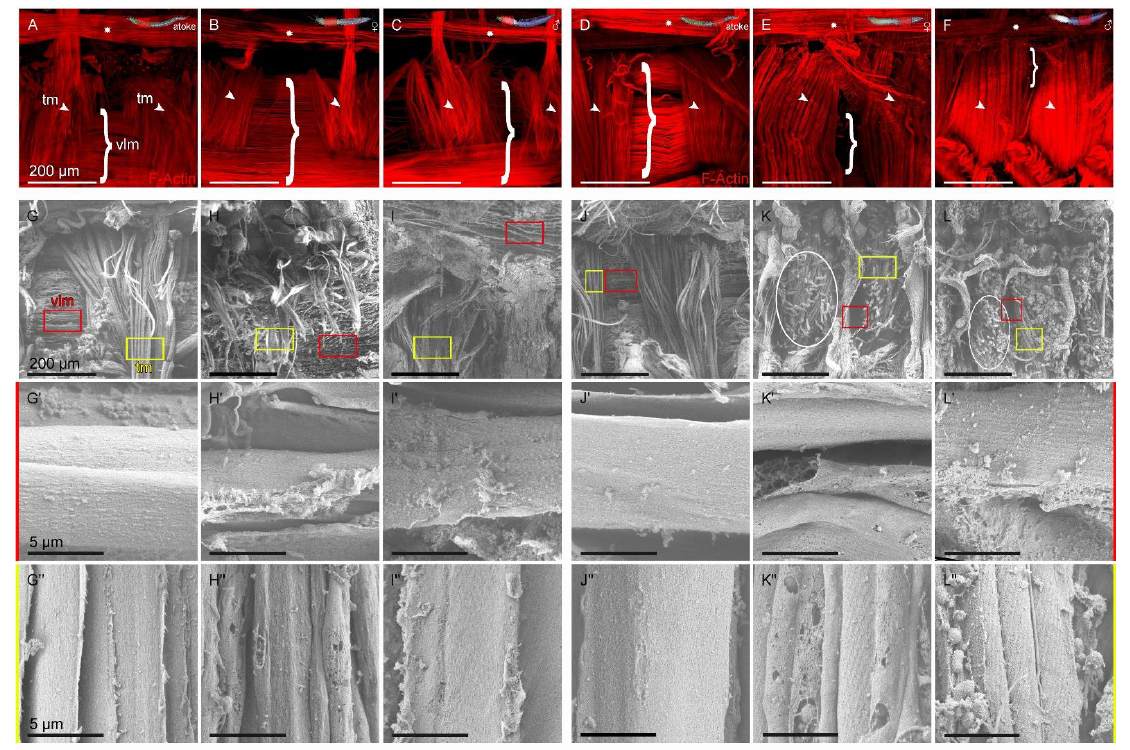
Figure 6. Ultrastructural comparison of ventral longitudinal and transversal muscle remodeling. ( A – F ) Overview of Phalloidin-stained ventral muscle filets with ventral longitudinal muscles (vlm, brackets) in parallel to the axochord (asterisks) and perpendicular running transversal muscles (tm, arrowheads) from anterior and posterior segments of the same worm. ( G – L ) Low magnification of the ventral muscles with vlm (red boxes) and tm (yellow boxes) in anterior and posterior segments highlighting the massive amount of vessels (circles in K , L ) in the posterior vlm and tm after maturation shown by scanning electron microscopy (SEM). ( G’ – L’ ) High magnification SEM of the vlm display bulges and small holes in anterior ( H’ , I’ ) or small holes and degenerating muscles in posterior segments ( K’ , L’ ) after sexual maturation, while ( G” – L” ) the high magnification of the tm reveal strong surface changes ( H” , I” ) often combined with resolution of the overall structure ( K” , L” ). Abbr.: tm transversal muscles, vlm ventral longitudinal muscles. Scale bars = A – L 200 µm, G ’– L ” 5 µm.